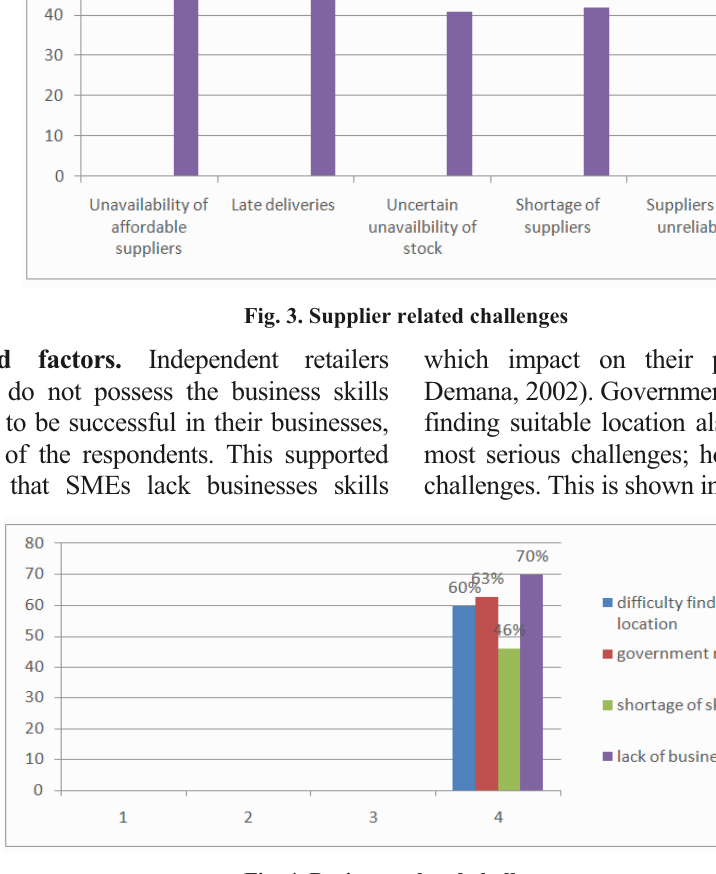
Fig. 4. Business related